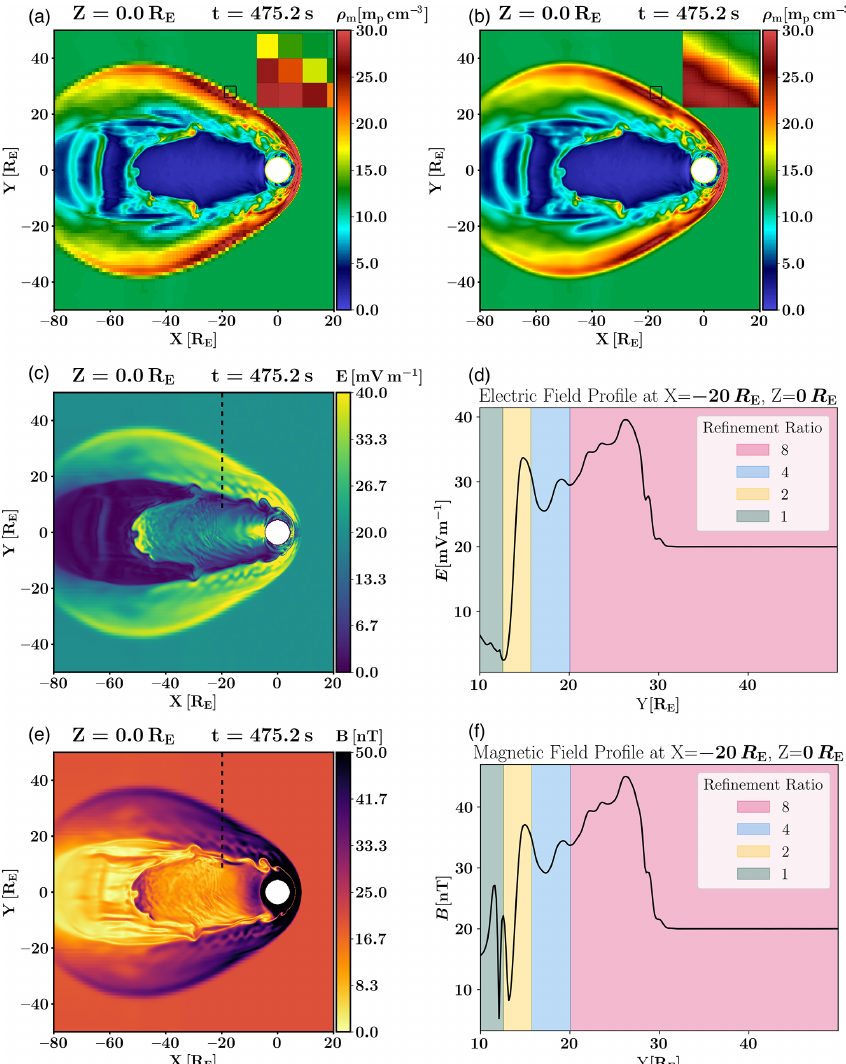
Figure 8. Vlasiator magnetospheric simulation results. (a) Mass density color map (on the AMR Vlasov grid) of a 6D AMR simulation. (b) Mass density color map (on the uniform FsGrid) of a 6D AMR simulation with the filtering operator in use. In panels (a) and (b) , m p stands for proton mass. There are four refinement levels, and they are treated with 0, 2, 4, and 8 filtering passes from finest to coarsest, respectively. The insets in panels (a) and (b) illustrate the mass density on the uniform field solver grid. The AMR Vlasov mesh is denoted by the black lines. The insets are taken from the regions highlighted by black squares in panels (a) and (b) . The step discontinuities visible in the inset in panel (a) are spatially co-located with the DCCRG grid cells. (c) Electric field magnitude color map (on the uniform FsGrid) with the filtering operator in use. (d) Electric field profile sampled along the dashed line in panel (c) . (e) Magnetic field magnitude color map (on the uniform FsGrid) with the filtering operator in use. (f) Magnetic field profile sampled along the dashed line in panel (e)